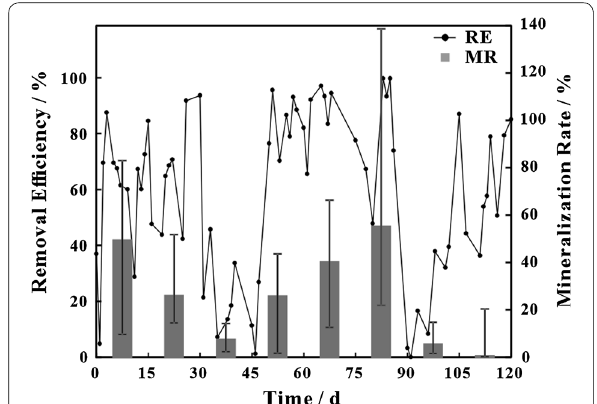
Fig. 1 Removal efficiencies (RE) and average mineralization rates (MR) of the biofilter with shifting of VOCs (inlet VOCs were changed every 15 days with the order of toluene, ethylbenzene, chlorobenzene, acetone, isopropyl alcohol, ethyl acetate, n‑hexane and